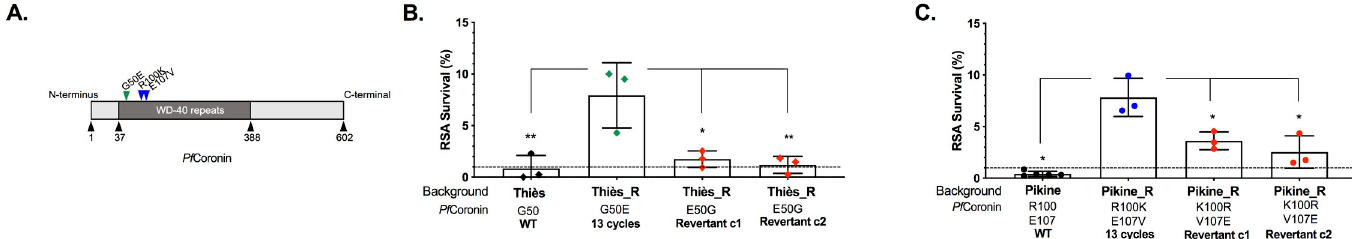
Fig 1. Pf Coronin is the major driver of artemisinin resistance in the in vitro evolved artemisinin resistant parasites Thi è s_R and Pikine_R. A. Map of the Pf Coronin protein indicating the positions of mutations in the WD-40 beta propeller domain associated with artemisinin resistance (G50E identified in Thi è s_R and R100K and E107V identified in Pikine_R). Ring-stage survival assay (RSA) survival percentage for B. two clones of the reverted pfcoronin G50E mutation in the Thi è s_R background (Revertant clone 1 and 2, red), and C. two clones of reverted pfcoronin R100K and E107V mutations in the Pikine_R background (Revertant clone 1 and 2, red) compared to their respective wildtype (WT) parasites (black). Previously published survivals for Thi è s_R (green) and Pikine_R (blue) are included [17]. Each data point represents an independent biological replicate, and the dotted line represents the 1% survival threshold, above which survival is considered resistant. Significance level is indicated by the asterisks, � p < 0.05, �� p < 0.01, determined using an unpaired two-tailed student t-test with Welch’s correction for data in B and Mann-Whitney U test for data in C.